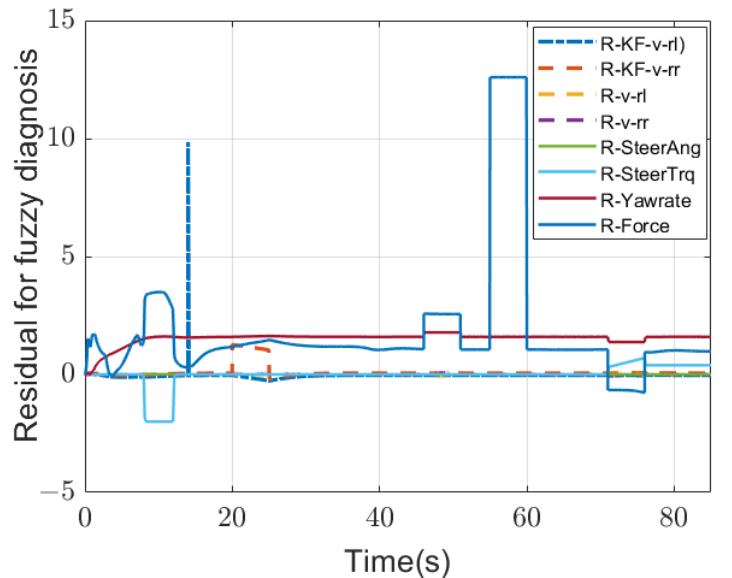
Figure 3. The eight residual changing trends that are used as the inputs for fuzzy